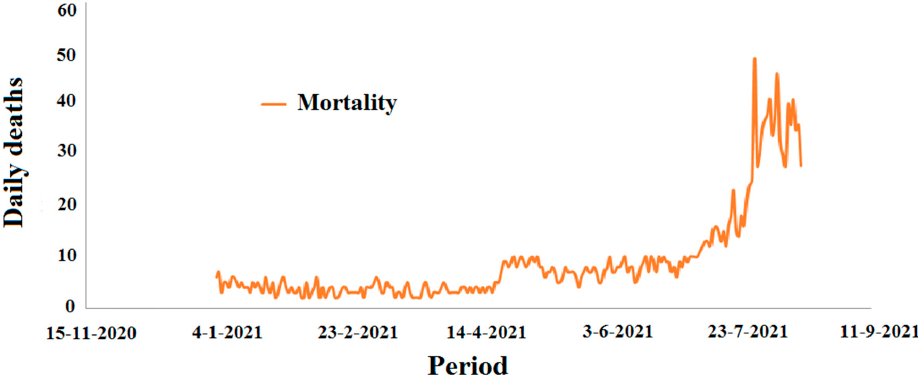
Figure 2. Mortality due to COVD-19 in Algeria in the period between 1 January 2021 and 15 August 2021.